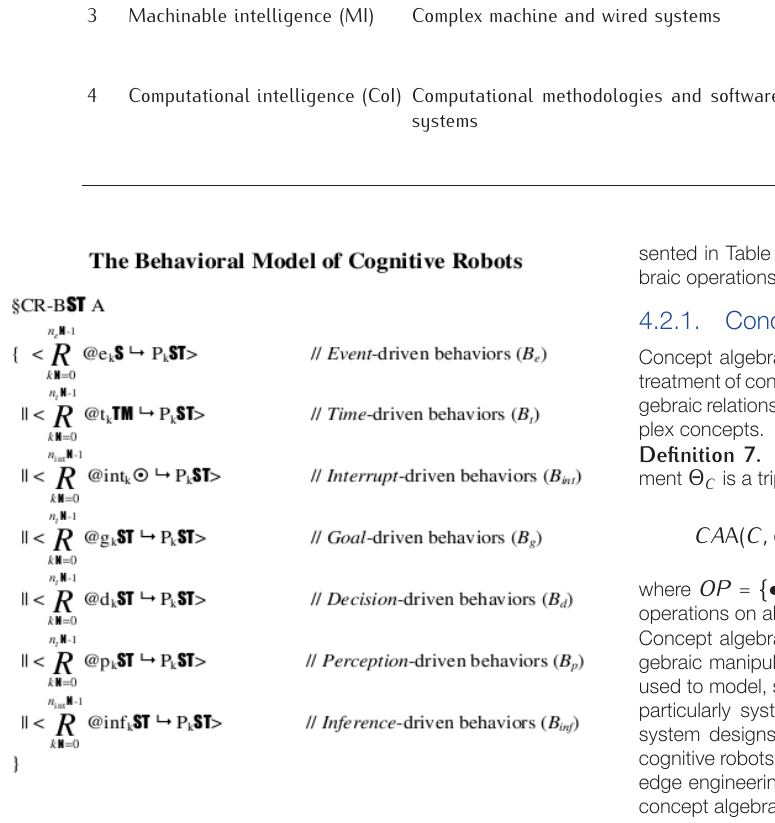
Figure 3. The behavioral model of a cognitive